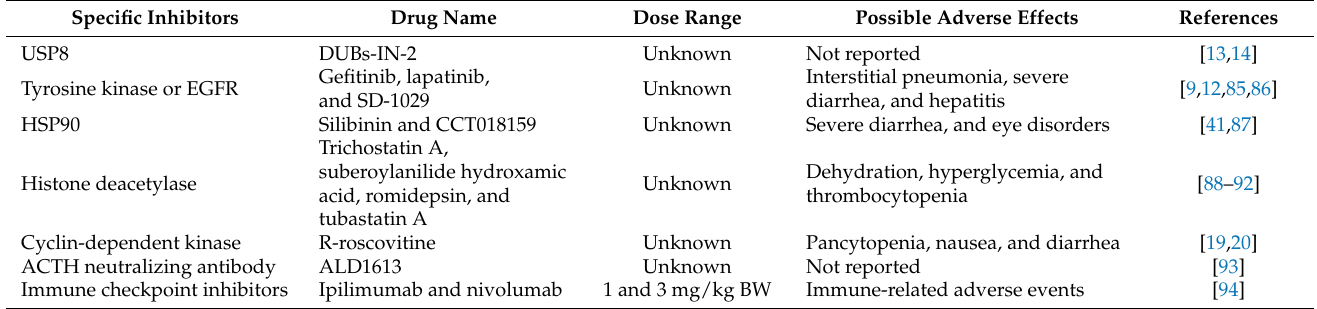
Table 2. Characteristics of drugs introduced for novel potential therapy. USP8, ubiquitin-specific protease 8; EGFR, epidermal growth factor receptor; HSP90, heat shock protein 90; ACTH, adrenocor- ticotropic